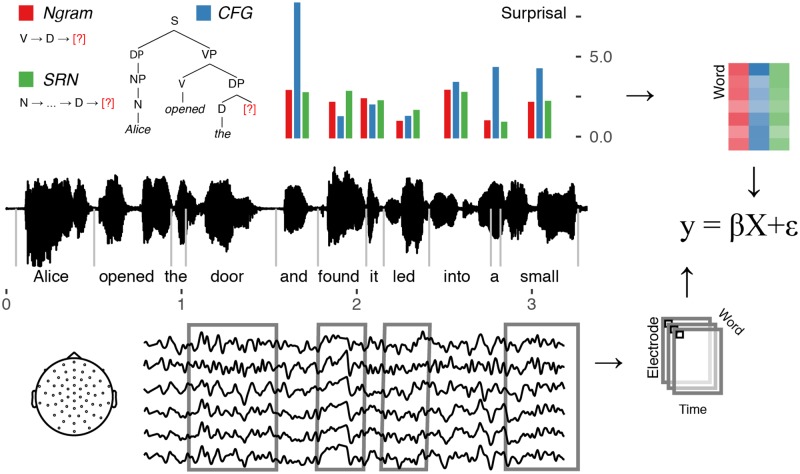
Language models and data analysis.Word-by-word surprisal values (top) estimated from one hierarchy-based and two sequential language models are time-aligned to the audiobook stimulus (middle). Epochs aligned with the onset of each word are extracted from filtered EEG data and amplitudes from each time-point and electrode serve as the dependent measure of a regression model (right) that includes surprisal values and low-level covariates as predictors.